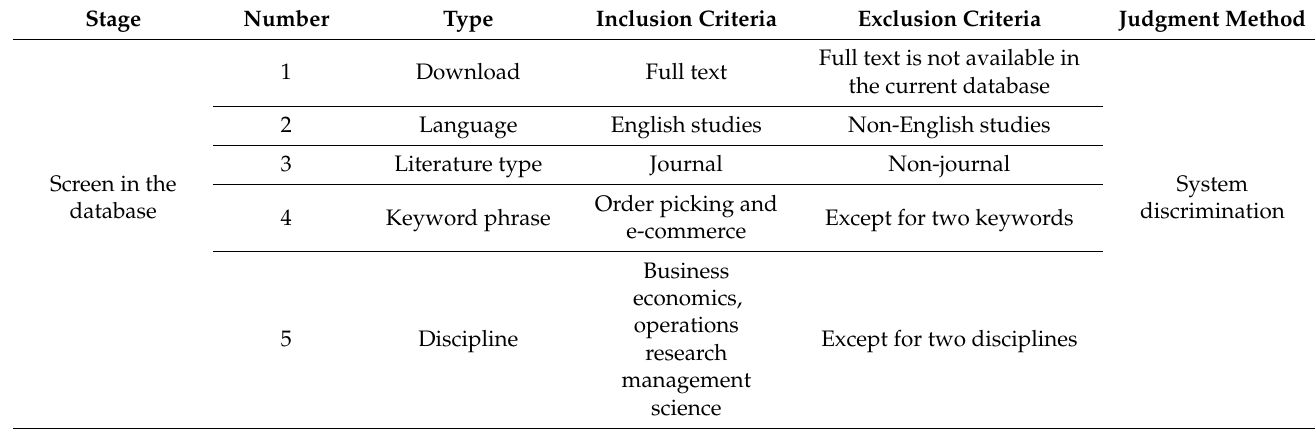
Table 1. The criteria of database retrieval and literature screening.